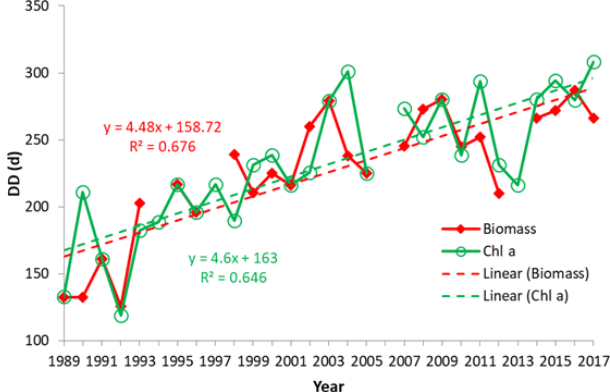
Figure 10. Trends in the duration of the vegetation period (DD), based on phytoplankton biomass and Chl a data, showing the re- gression lines and corresponding formulas (Wasmund et al.,